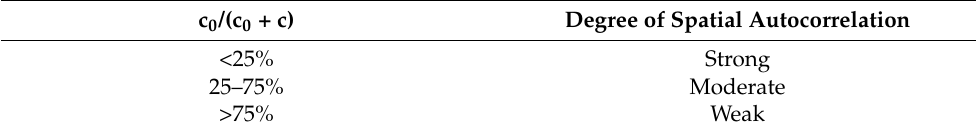
Table 3. Correspondence table for degree of spatial